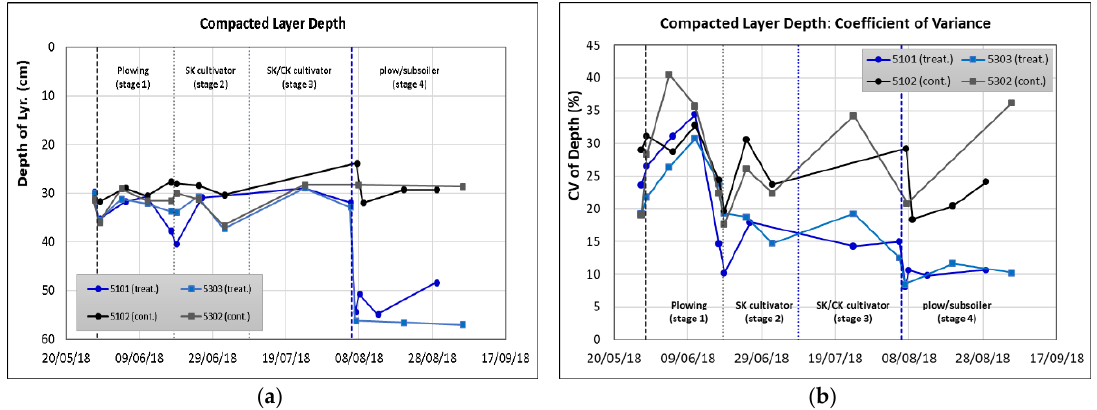
Figure 5. Soil compaction measurements in representative ponds during the course of the experiment. ( a ) Depth of the compacted layer; ( b ) Coefficient of variance between measurements (replicates) along the grid line.